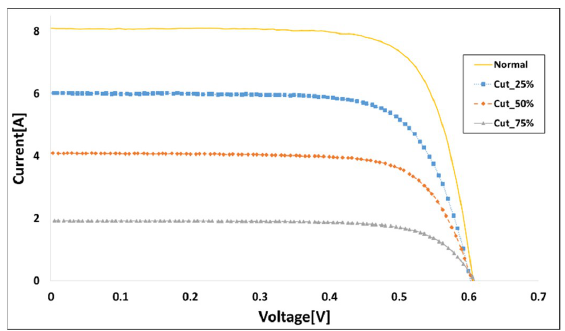
Figure 16. Current-voltage characteristic curve according to the cut ratio.